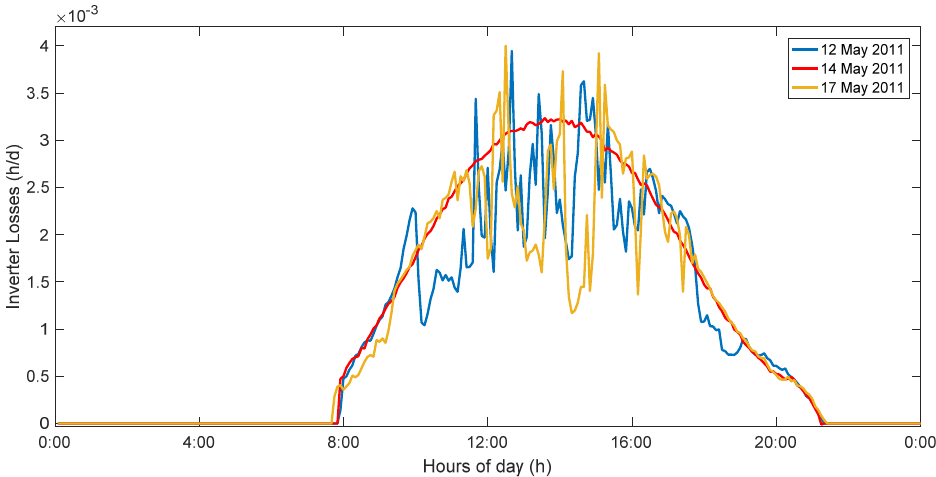
Figure 23. Daily profiles of inverter losses obtained during 12, 14 and 17 May 2011.